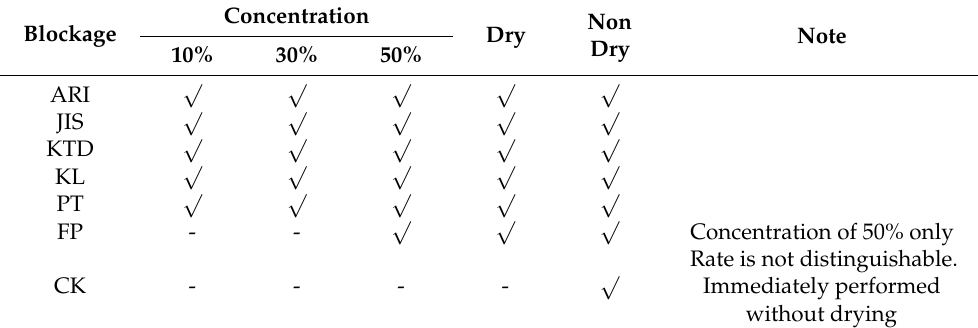
Table 3. Experimental progress checklist.